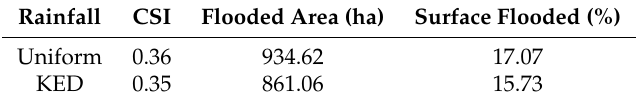
Table 7. Comparison of maximum flooded areas between uniform and KED